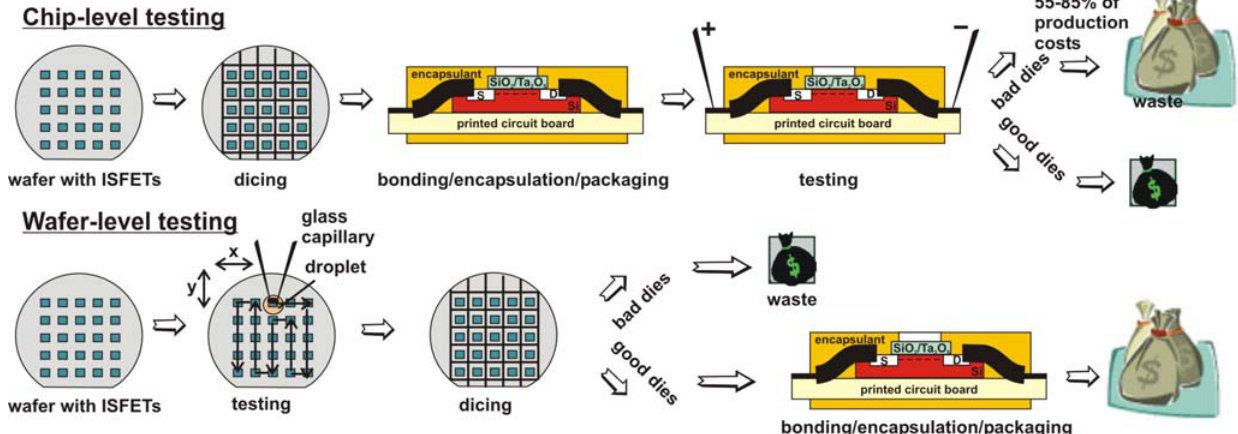
Figure 1. Wafer-level vs. chip-level